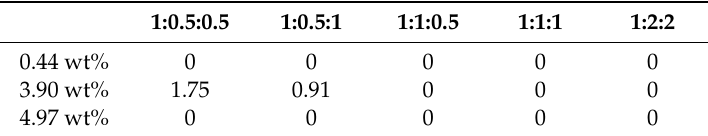
Table 8. Comparison of the maximum molar quantity of C 2 H 6 per unit weight of photocatalyst with illumination time among di ff erent molar ratios of CO 2 / H 2 / H 2 O and Pd loading weight with UV light illumination (unit: µ mol /